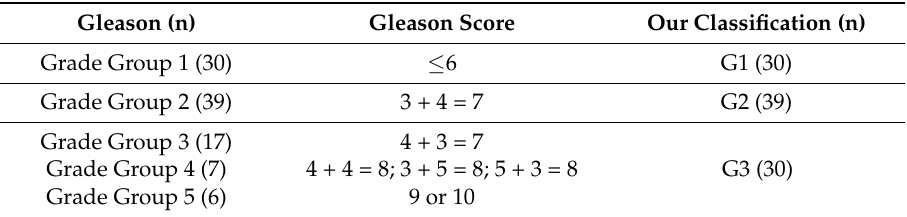
Table 1. Patients characteristics related to Gleason score.